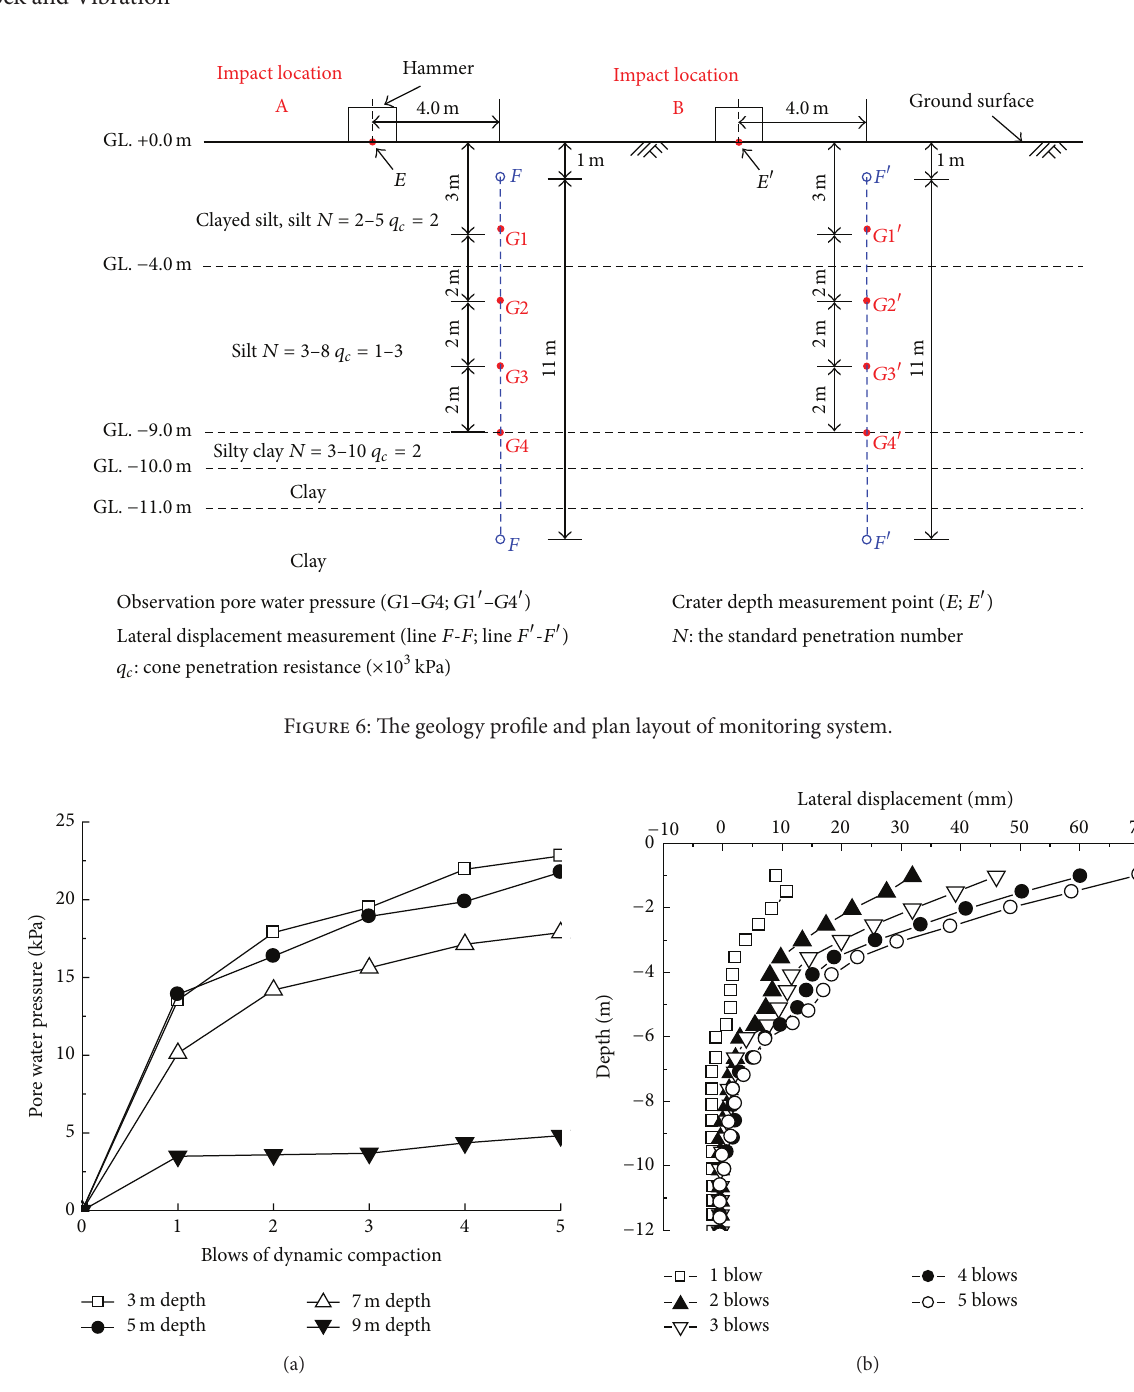
Figure 7: Illustration of the measured data of (a) pore water pressure with each blow of dynamic compaction and (b) lateral displacement at different depth with each blow of dynamic